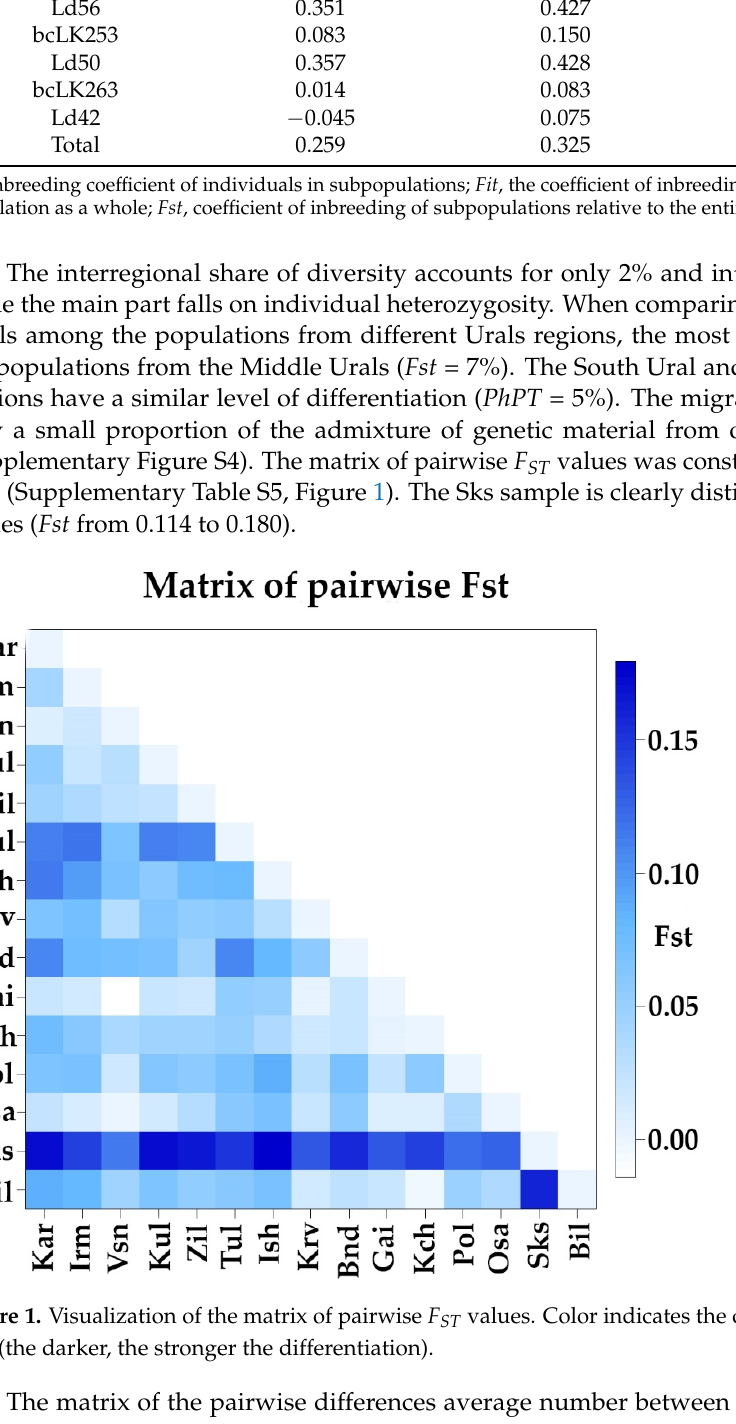
Table 3. Genetic structure and differentiation of the studied populations of L. sibirica . Locus Fis Fit Fst bcLK189 0.138 0.198